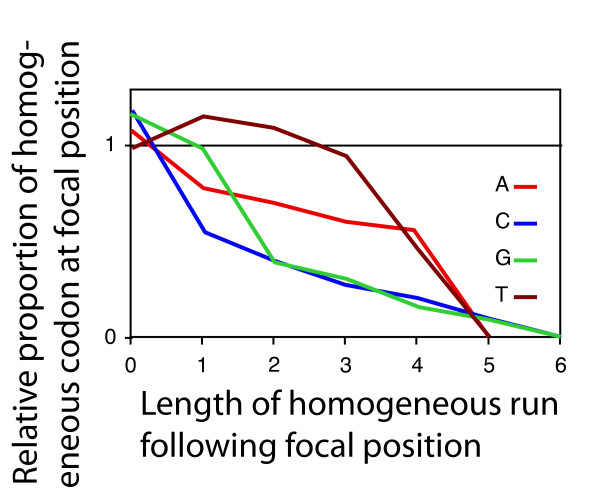
The under-representation of long mononucleotide repeats in coding regions of M. tuberculosis is a consequence of a context-dependent codon choice. Codons consisting of three identical nucleotides ('homogeneous codons') are avoided at positions followed by one or more nucleotides of the same type. The under-representation increases with increasing number of identical nucleotides following. Each line represents data for one type of nucleotide (indicated by the line color).